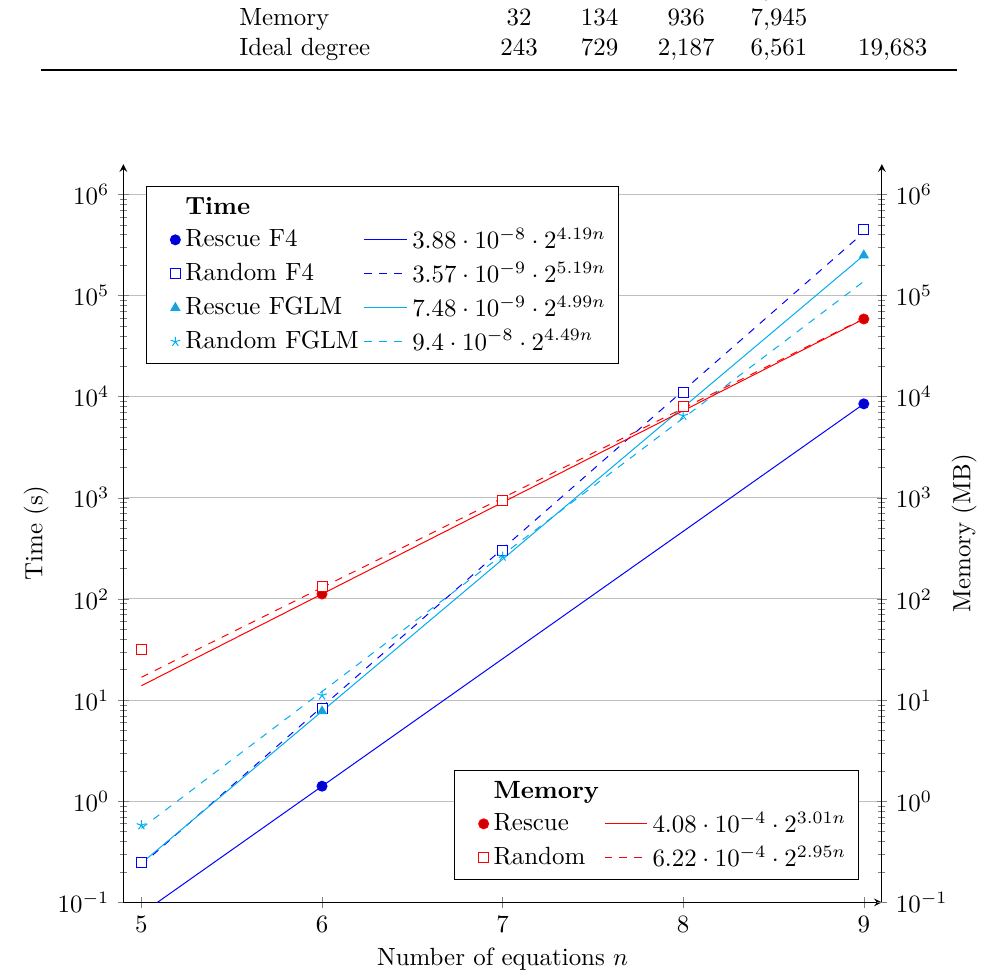
Figure 13: Benchmarks of multivariate root finding with Magma using 1 CPU core of an Intel Xeon Gold 5218, for Rescue–Prime and Rescue–Prime-like systems ( 𝑛 equations of degree 3), with 𝑝 = 18446744073709551557 and 𝑚 = 3. 3-round and 4-round Rescue-prime respectively correspond to 𝑛 = 6 and 𝑛 =